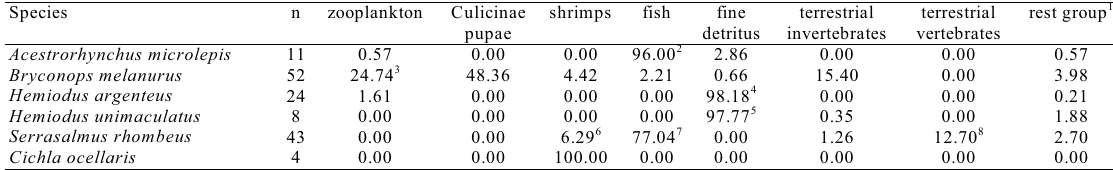
Table 4. Diet of fishes from the open water habitat of Brokopondo Reservoir, 2002-2005. Data are average percentages by volume of each food item in stomachs with >50% fullness (n). The rest category contains mainly aquatic insects (1.99% in B. melanurus ) and/ or chitinous remains 1 . In 6 stomachs of A. microlepis the prey species was Bryconops melanurus ; in other stomachs the prey species could not be identified 2 . Zooplankton in stomachs of B. melanurus consisted mainly of Ostracoda (17.60%) and Cladocera (7.03%) with only few Copepoda (0.11%) 3 . Detritus in Hemiodus argenteus and H. unimaculatus included 1.41% and 2.35% sand, respec- tively 4,5 . In one stomach of Serrasalmus rhombeus a crab (1.26%) 6 was present and in 6 stomachs the remains of white-lipped peccaries ( Tayassu pecari ) ( e.g. hoofs, hair; 12.7%) were found 8 ; fish prey species identified from S. rhombeus stomachs were B. melanurus (3 stomachs), Hemiodus spp. (3 stomachs), Plagioscion squamosissimus (1 stomach) and S. rhombeus (1 stomach) 7